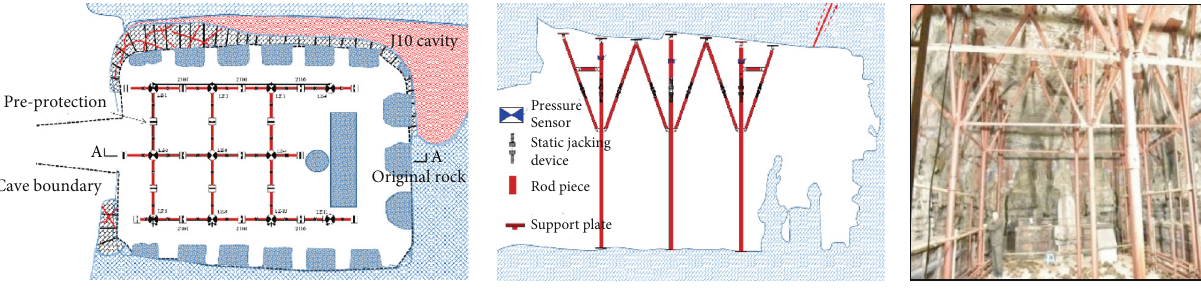
Figure 5: Yuanjue Cave roof preprotection system.